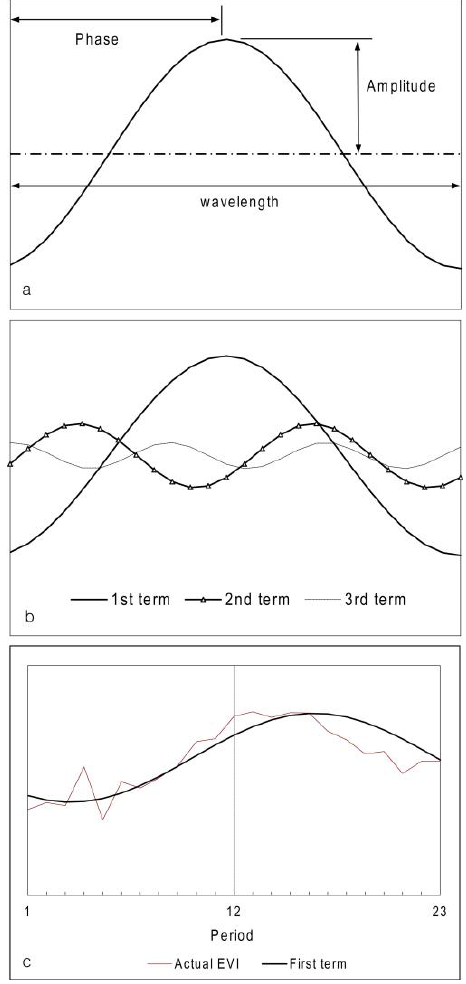
Figure 2. Main components of harmonic analysis (a), and a schematic illustration of the first three harmonic terms, 1st, 2nd, and 3 rd terms (b). Principal seasonality of mid-latitude regions is mostly well represented by the first